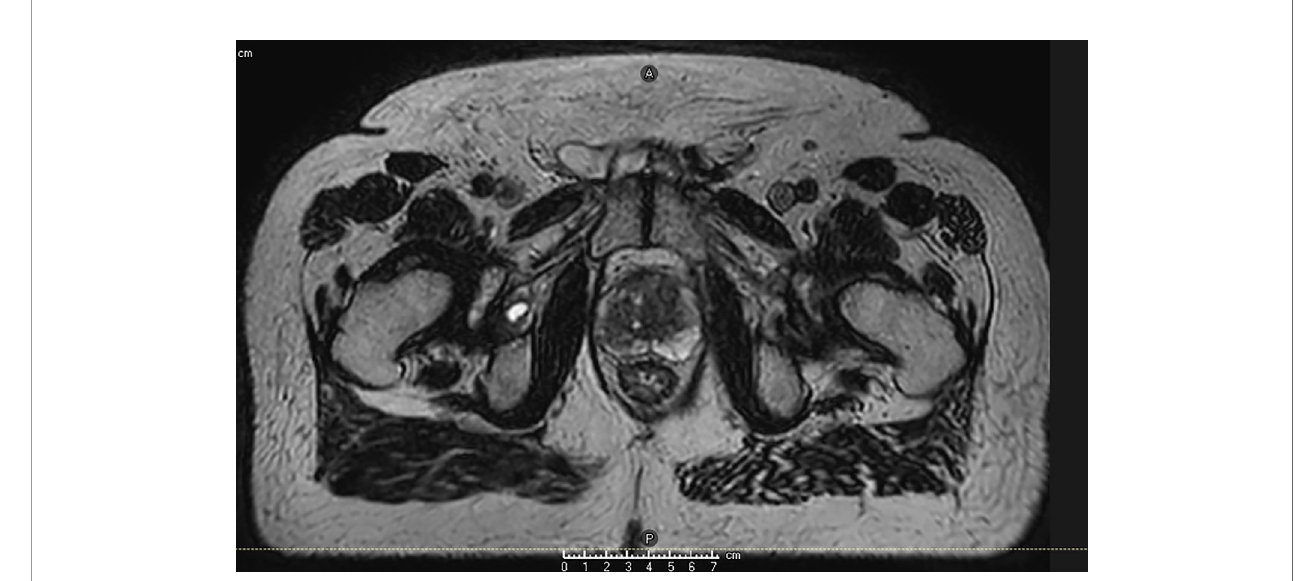
FIGURE 1 | Axial image of the prostate (T2 2 min scan) from the